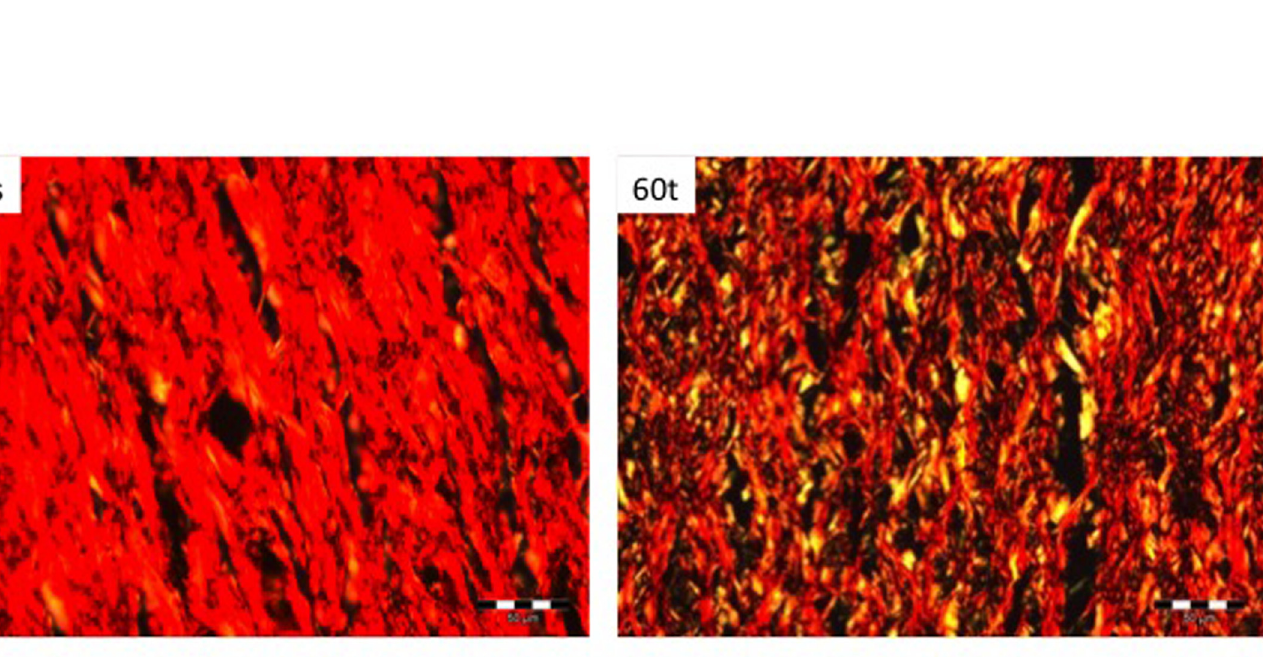
PLOS ONE | DOI:10.1371/journal.pone.0132131 July 7, 2015 11 /